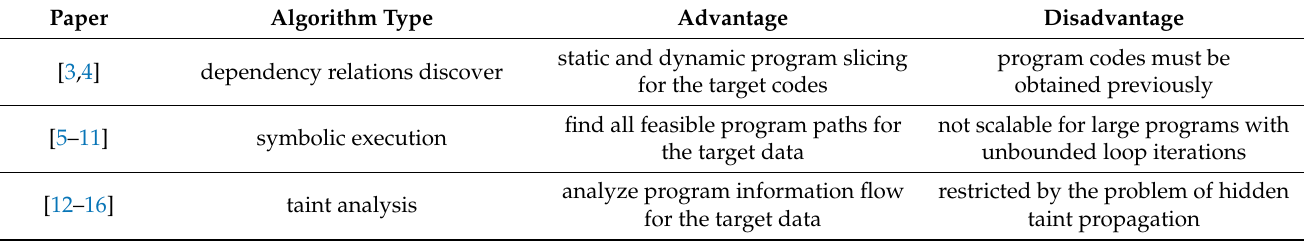
Table 1. A summary of reviewed papers suitable for the reverse modification of binary code and